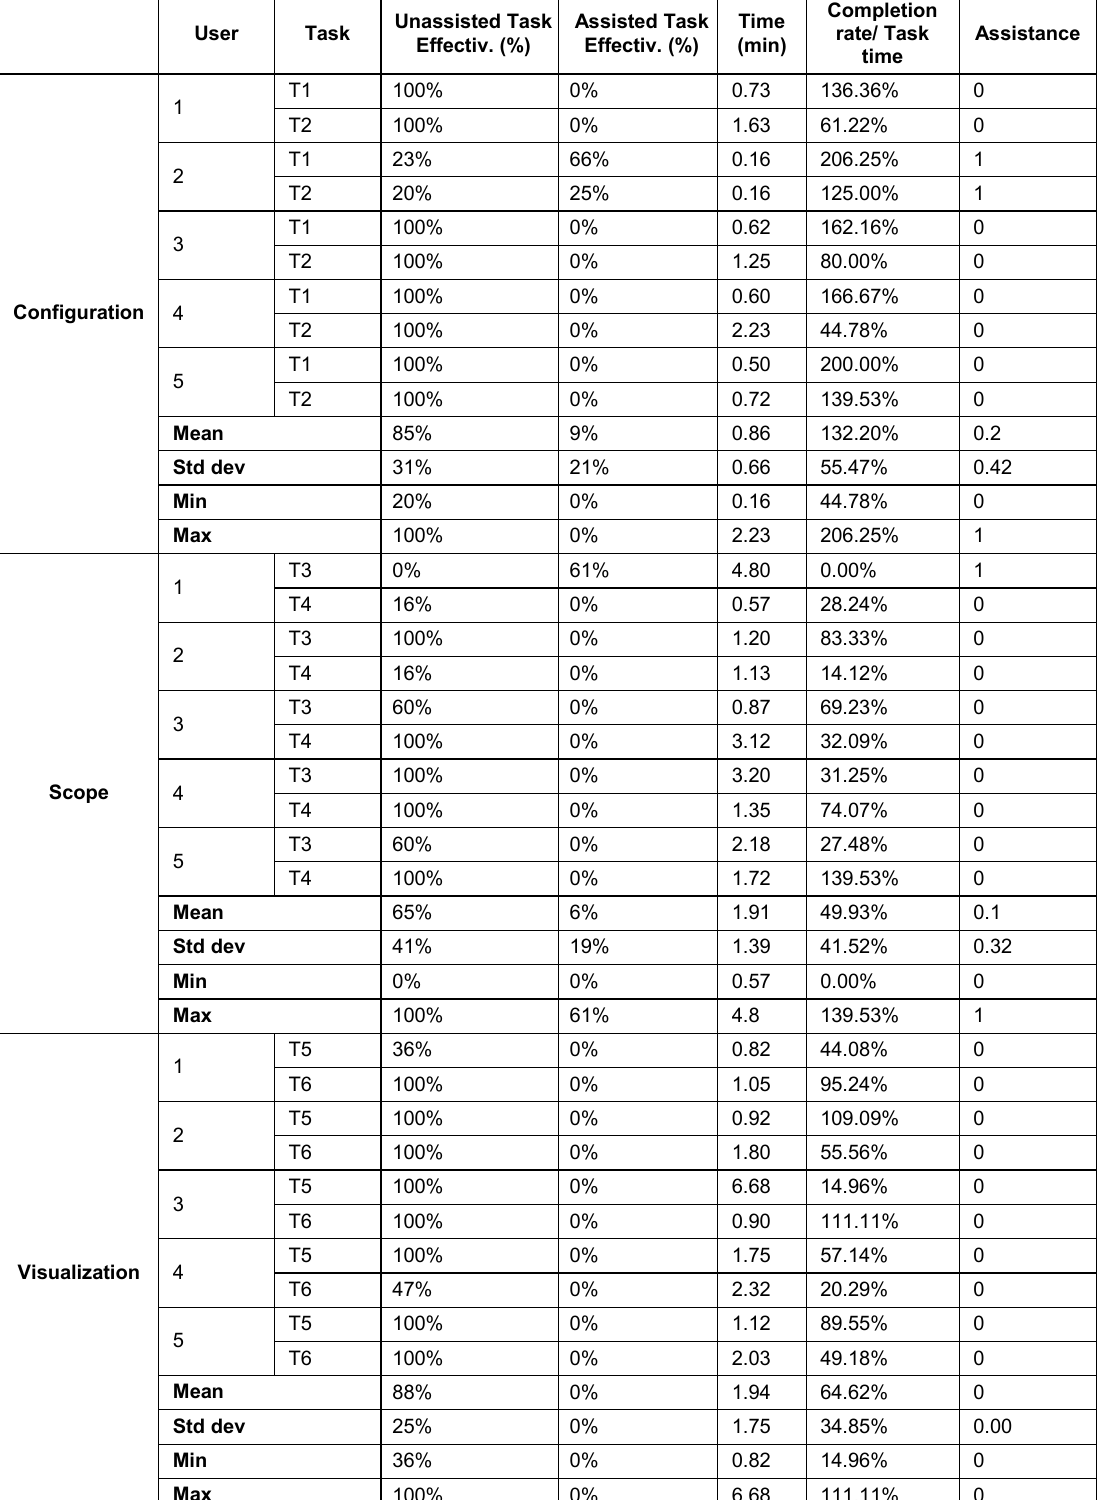
Table 4. Results of Effectiveness and